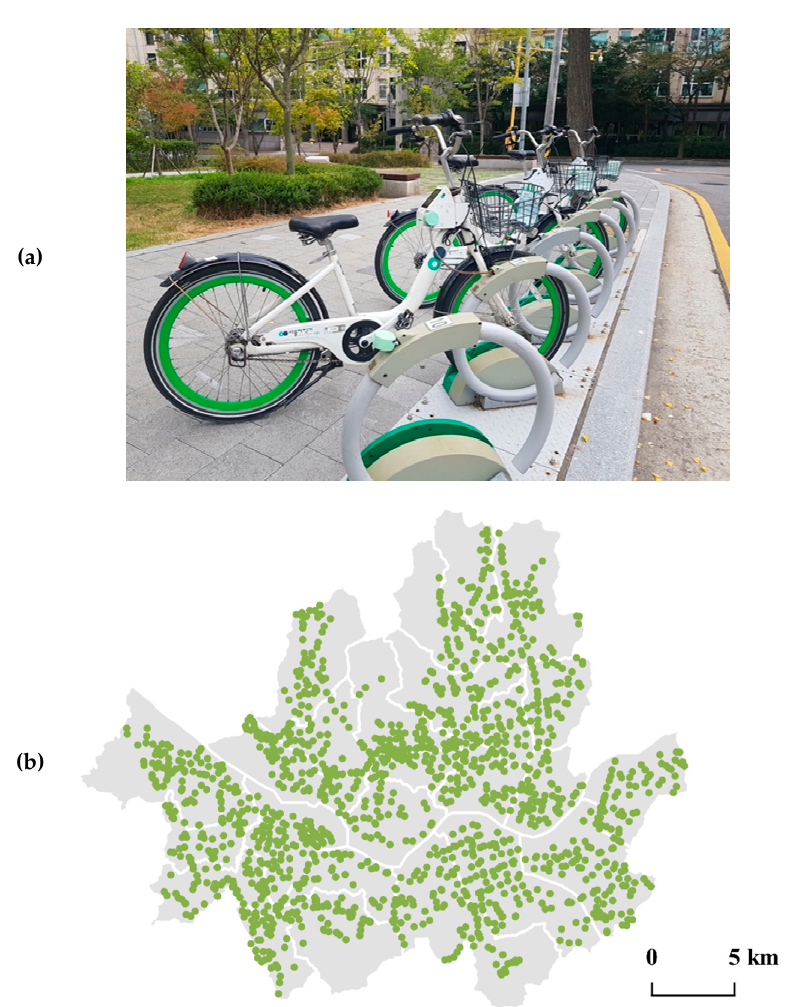
Figure 2. ( a ) A bike sharing station in Seoul; ( b ) locations of bike sharing stations in Seoul as of mid-2019.